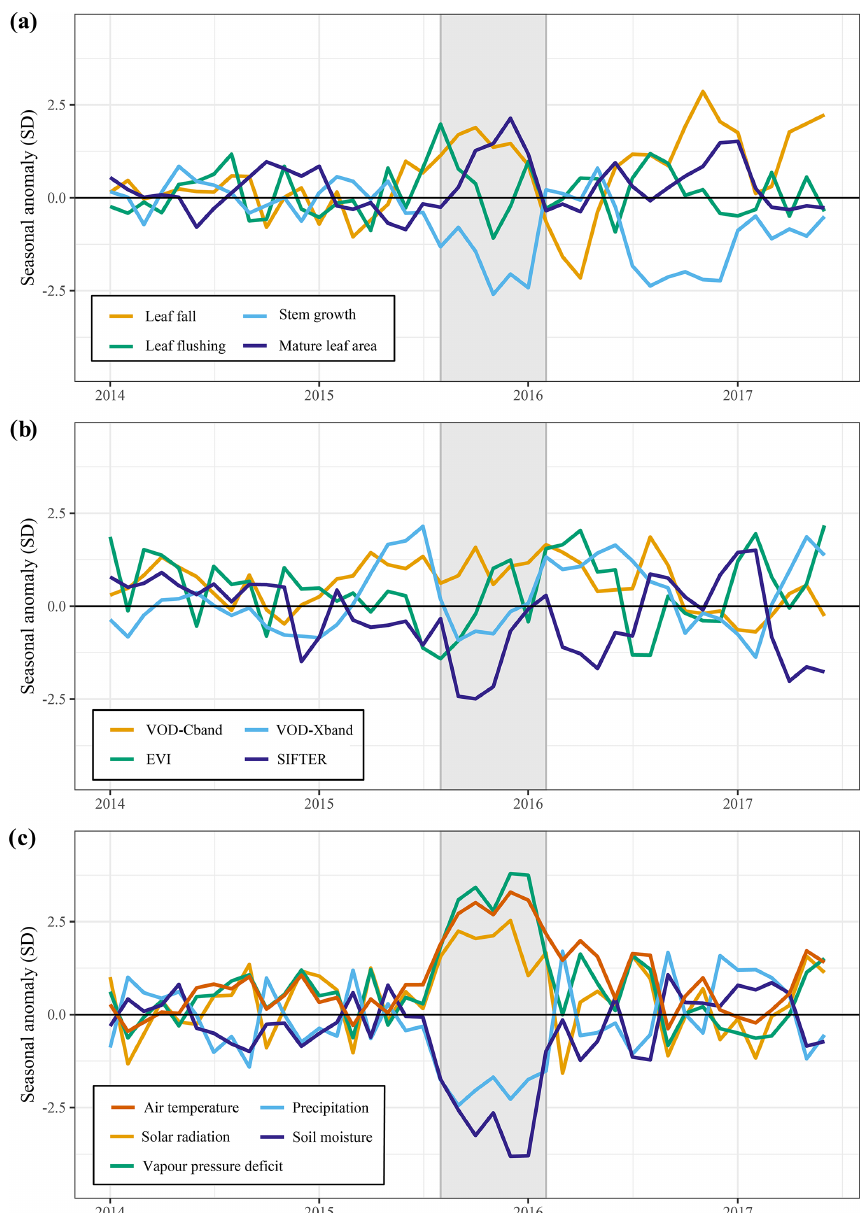
Figure 5. Responses of above-ground growth and remotely sensed vegetation properties to the 2015 El Niño drought and key climatic variables. All graphs show the trend in the standardized seasonal anomaly, the deviation from the monthly mean divided by the standard deviation of that month. Leaf fall and stem growth (a) are derived from the two separate XGBoost models providing monthly values from January 1982 until September 2019. Mature leaf area (a) is the sum of flushed leaves from 2 to 5 months in the